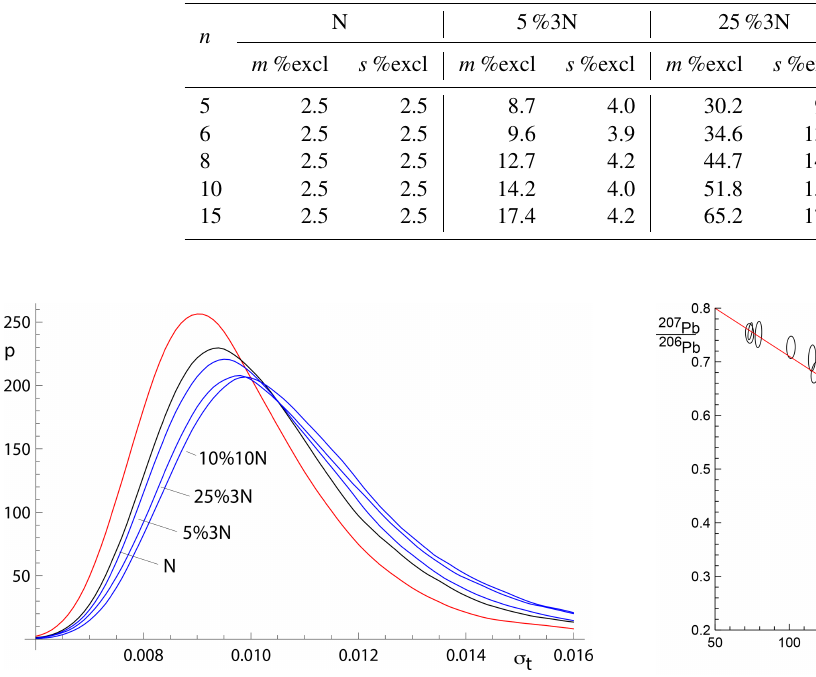
Figure 6. Kernel density estimates for age uncertainty calculated with SPINE on 10000 simulated datasets with n = 10 and several uncertainty structures. The kde for those datasets for which all | r k | < h is in red, the kde for datasets with Gaussian-distributed un- certainties is in black, and the kde for all of the datasets for 5%3N, 25%3N, and 10%10N, respectively, are in blue.